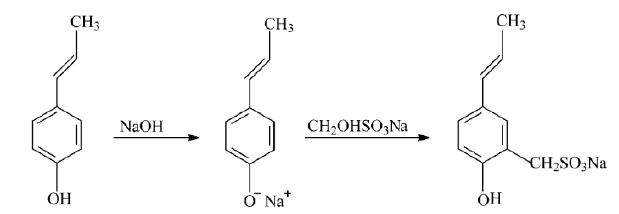
Figure 6. Sulfomethylation of lignin sodium sulfite and formaldehyde [86].